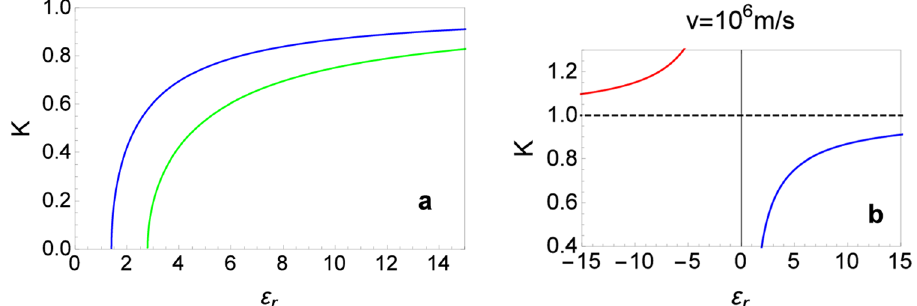
Figure 2. Luttinger parameter K dependence on the dielectric constant ε r for fixed values of the Fermi velocity v . ( a ) The blue (black) and green (grey) curves are for v = 10 6 m/s and v = 5 × 10 5 m/s, respectively, and they indicate that for sufficiently large values of ε r , the system becomes non-interacting ( K = 1), while for smaller values of ε r the interaction is repulsive ( K < 1). ( b ) A proposal to obtain attractive interactions K > 1 by changing the sign of the dielectric constant (red/grey curve) for a sample with v = 10 6